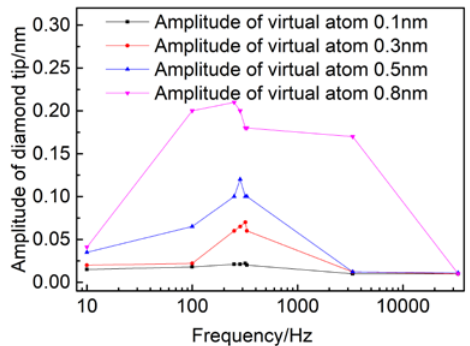
Figure 2. Vibration amplitude of the diamond tip with vibration amplitude of the virtual atom. Vibration frequencies in 8 cases are 10, 100, 250, 285, 319, 330, 3.33 × 10 3 , 3.333 × 10 4 GHz, respectively.